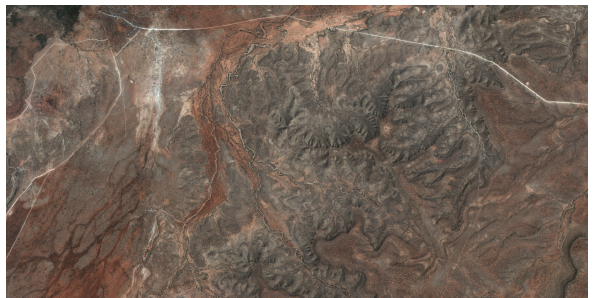
Figure 1. Sample of a rendered composite